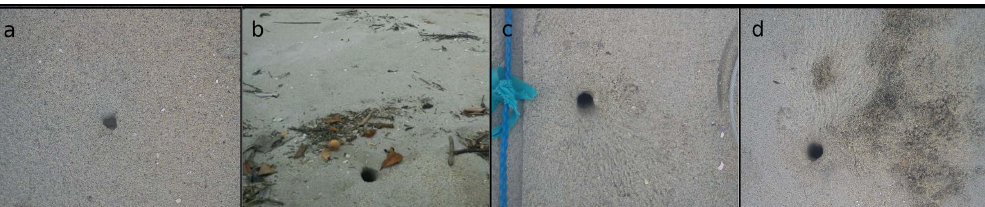
Figure 2. Categories of signs of occupation. Examples of each of the four categories of intensity of signs of occupation of Ocypode quadrata : a- none (no sign of occupation); b- subtle (barely recognizable tracks and/or excavated sand; only noting the definition of the internal perimeter); c- moderate (obvious presence of sand, or tracks, and internal perimeter definition); d- strong (presence of more than one clear sign and/or a very prominent one).